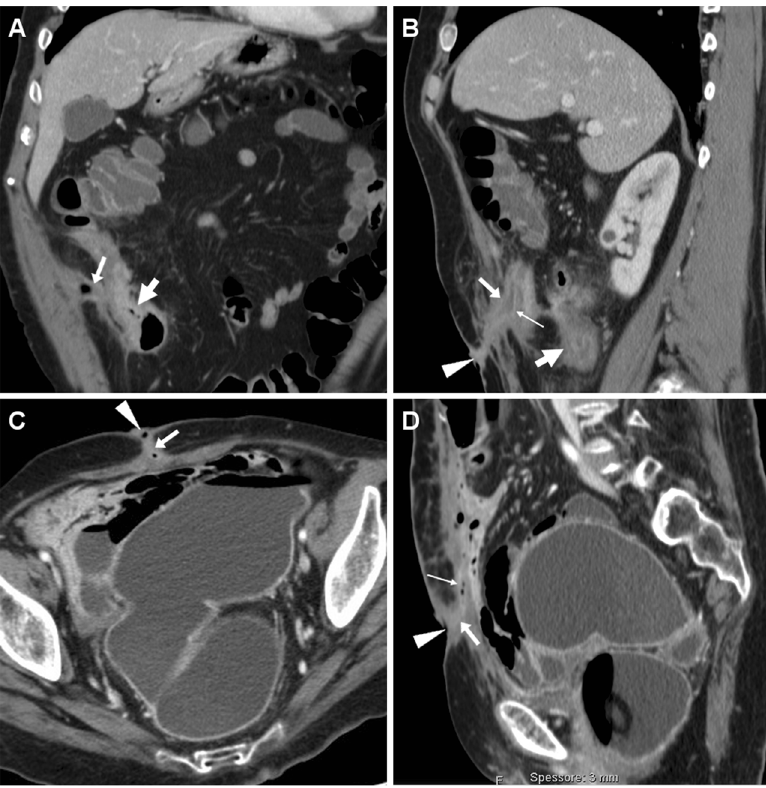
fat-suppressed T1-weighted acquisition ( B ) showed mucosal hyperenhancement along ECF track (thin arrows) and at site of internal opening (*). Surgical treatment required fistula debridement plus